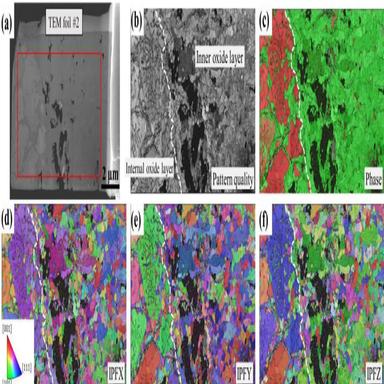
TKD images at the internal-inner oxide layer interface of T91 after exposure in SCW at 600 °C for 1500 h. (a) SEM image, (b) pattern quality map, (c) phase map and (d-f) IPF maps.